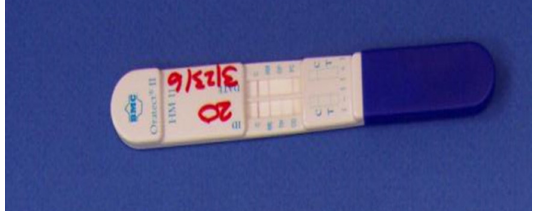
Figure 11. Branan Medical Oratect ® saliva testing system [48].